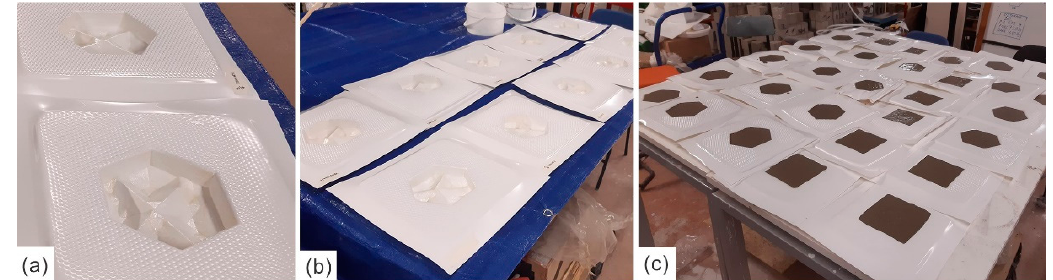
Figure 3. Photographs illustrating the casting process. ( a ) Vacuum formed mold from negative CNC’ed model ( b ) Vacuum form molds ( c ) Concrete casting.